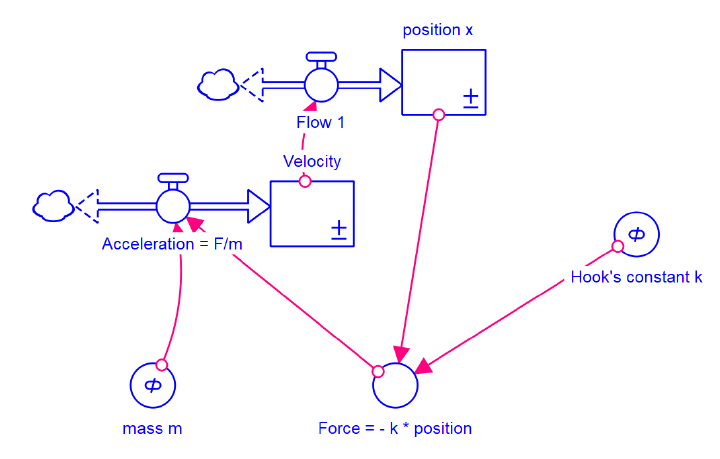
Fig. 18. Spring-mass stock-and-flow